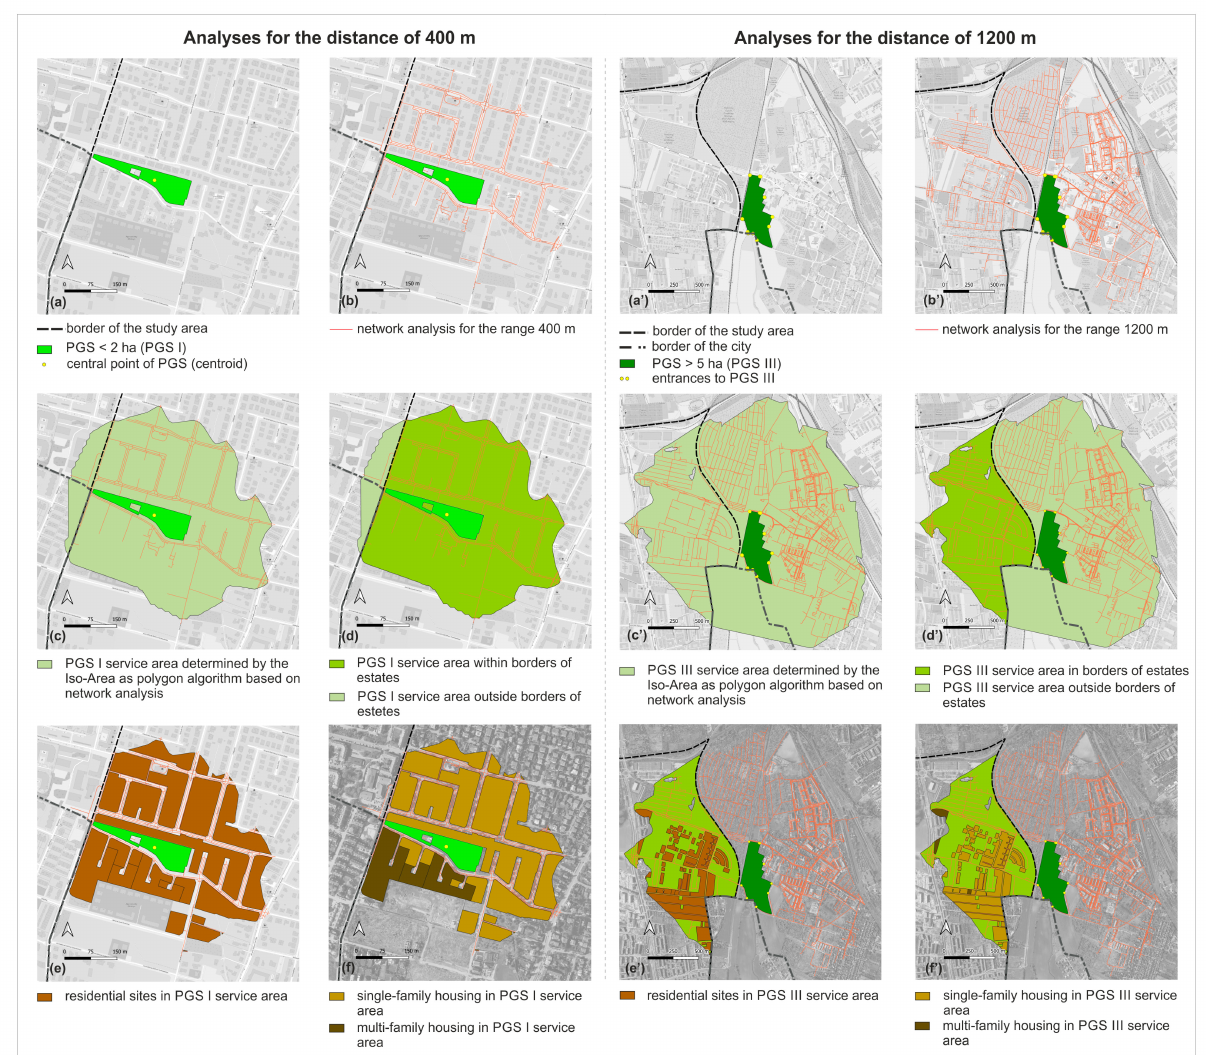
Figure 3. The procedure for determining residential development sites within the service areas of PGS, examples of analyses performed for the walking distance of 400 m and 1200 m. Analyses for the range of 800 m according to the adopted procedure were carried out in the same way as for 1200